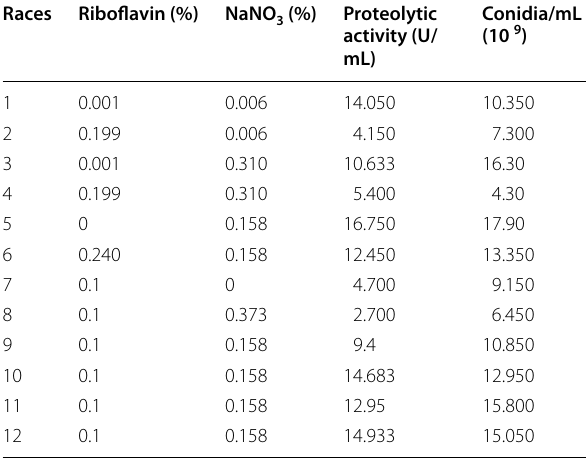
Table 4 Experimental design with 12 trials used to perform the response surface methodology